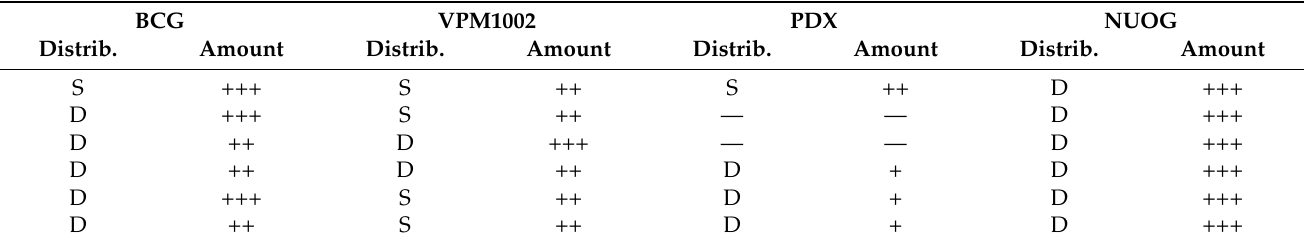
Table 1. Calcification in the central necrosis of caseous granulomas of goats (n = 6 per vaccine group) after subcutaneous injection of BCG, VPM1002, PDX or